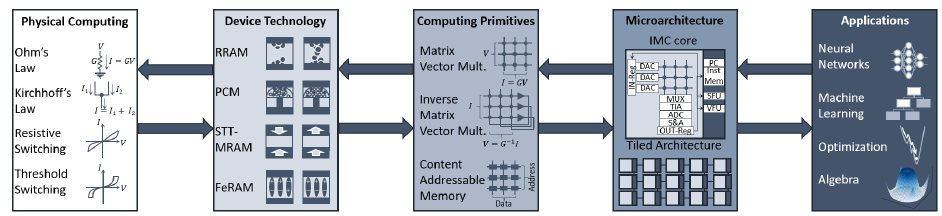
Figure 1. A conceptual illustration of the different scales of in-memory computing. Computing relies on fundamental physical laws that are implemented in various types of memory devices and circuit designs. To perform large-scale computation, new architectures have to be developed for accelerating real world applications. New applications can also arise given the possibility of performing highly-parallel computation. The design and optimization of each different level should be performed by considering all the hierarchical